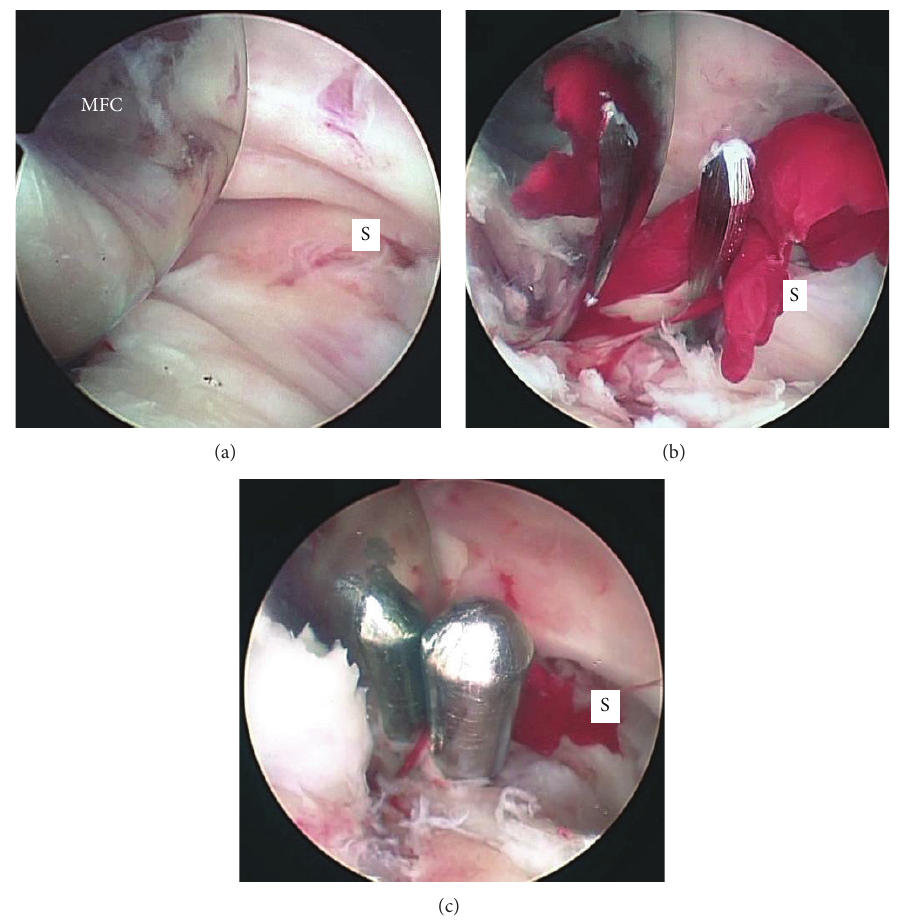
Figure 4: Arthroscopic views of the posterior compartment. The posterior septum was confirmed when viewed from the posteromedial portal (a). The septum was perforated by using a 3.0 mm Kirschner wire that was inserted from the posterolateral portal protected by a sheath (b). A 4.0 mm rod from the posterolateral portal was inserted into the initial hole created in the septum by using the Kirschner wires (c). MFC, medial condyle of the femoral component; S,